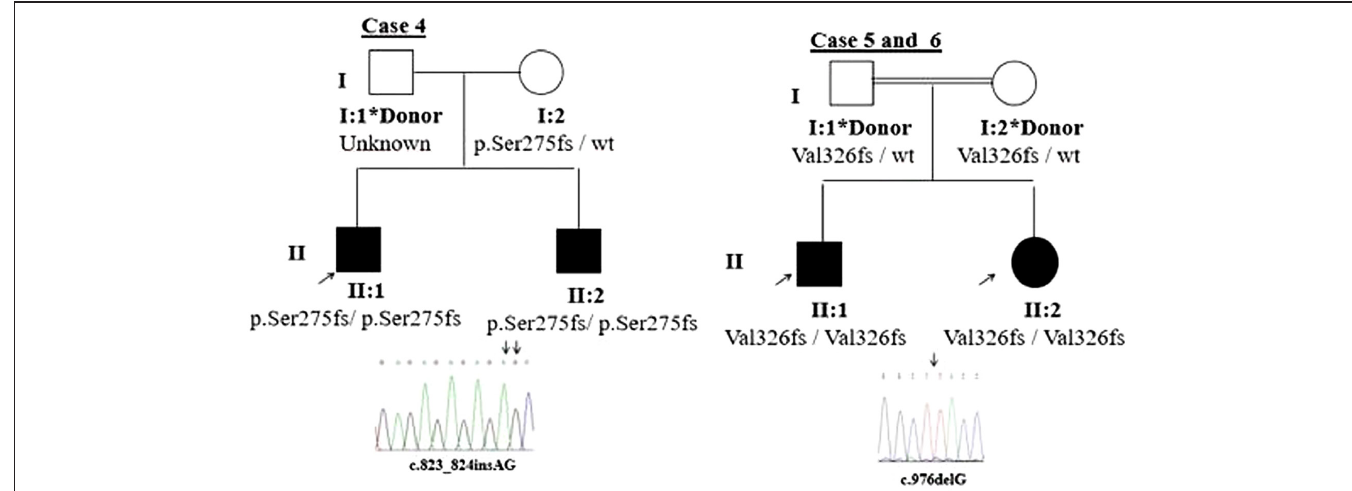
Figure 3. Sequence results of Cases 4, 5,